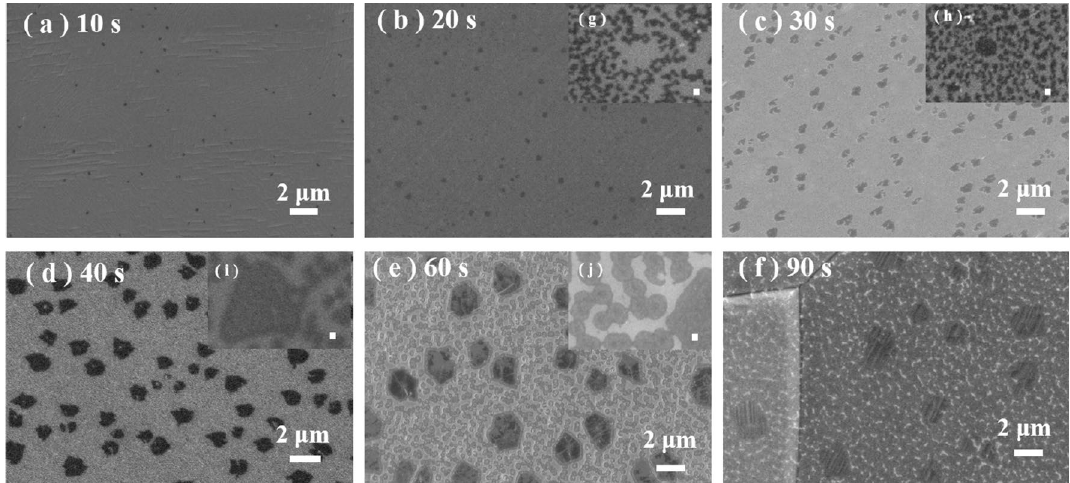
Figure 5. (a)–(f) SEM images of graphene growing on polished Cu at different growth times (10–90 s) at 850 °C with Ar:H 2 :CH 4 = 30:10:0.4, 50 W. The scale bar is 2 µm. ( g – j ) SEM images of graphene transferred onto SiO